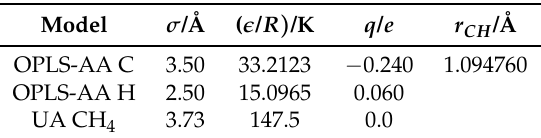
Table 5. Parameters of the methane models used in this work. R = 8.31451 J · mol − 1 · K − 1 is the molar gas